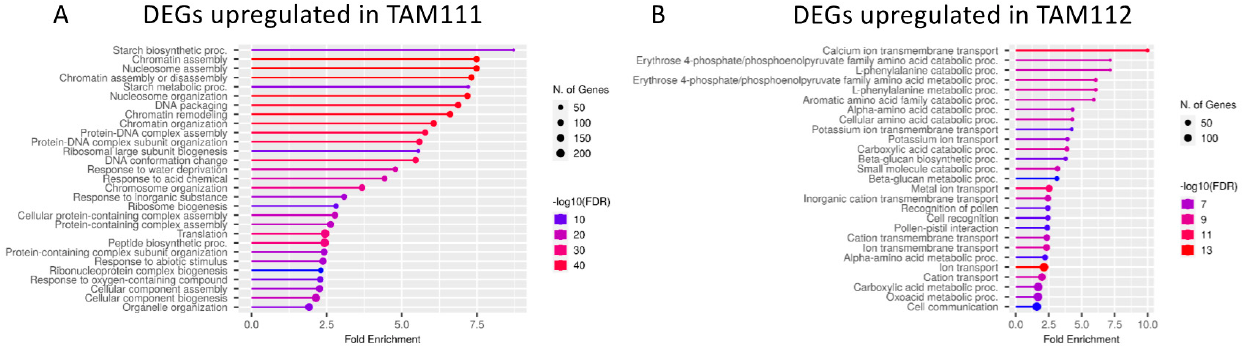
Figure 2. Plots of gene-ontology biological pathway analysis results of genes from 14 DAF expressed higher in TAM111 ( A ) or TAM112 ( B ). Categories ( X -axis) are sorted by fold enrichment ( Y -axis). Color presents the relative –log 10 FDR from low (blue) to high (red). The size of the circle represents the number of genes classified in that category.